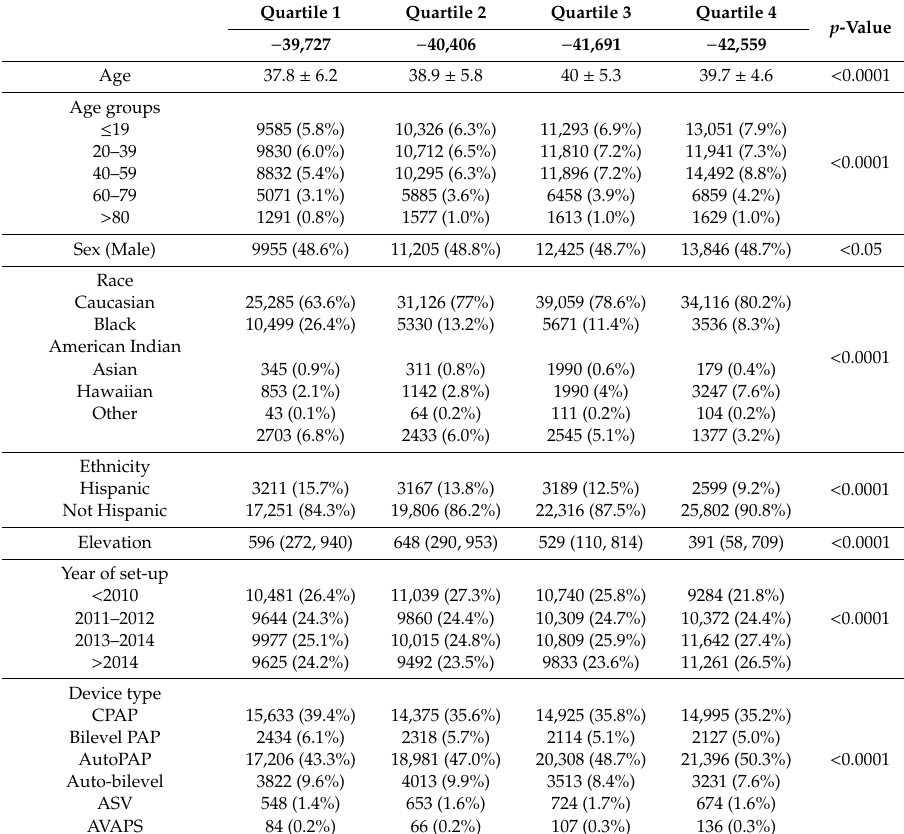
Table 1. Demographics of participants by income quartile.